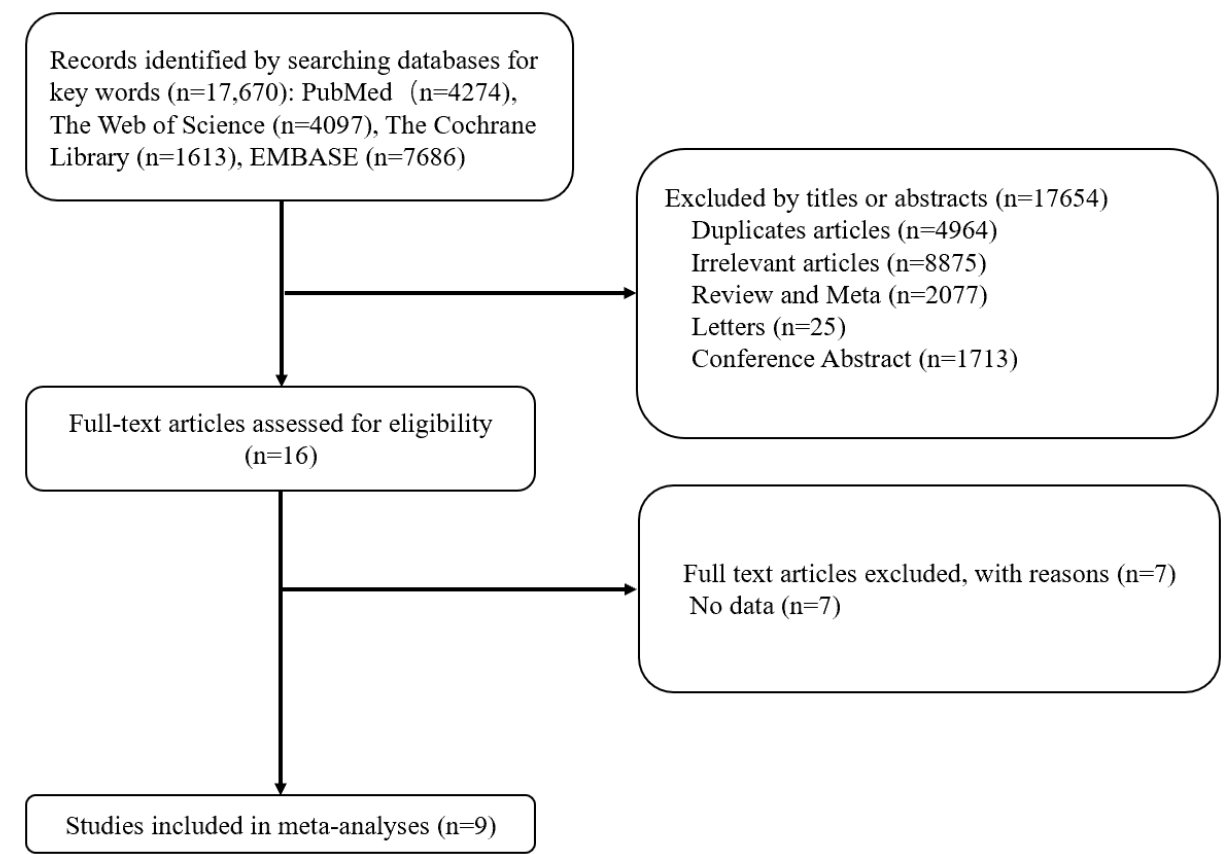
Figure 1. Flowchart of the screening and selection of